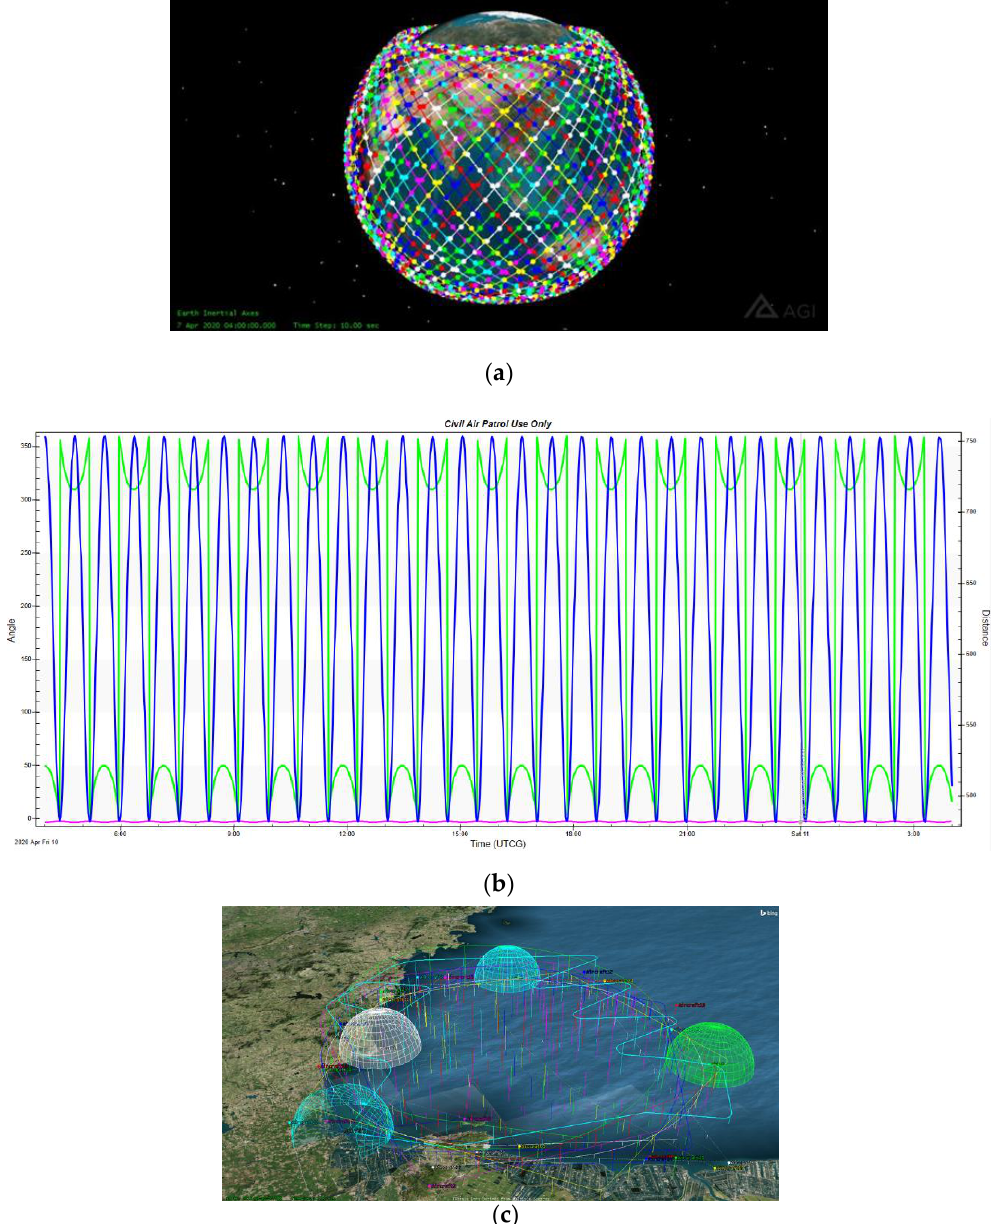
Figure 4. Simulation scenario design. ( a ) Satellite orbit. ( b ) The distance between visible satellites (24 h). ( c ) Aircraft scenario. Table 1. The orbit parameters of